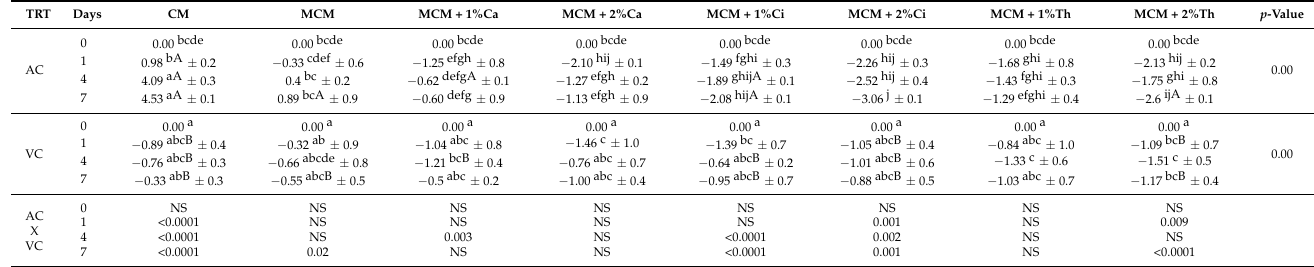
Table 8. Population changes of Enterobacteriaceae (log (N0/N) ± SD CFU/g) in marinated camel meat with essential oils under aerobic (AC) and vacuum (VC) conditions after storage at 10 ◦ C for 0, 1, 4 and 7